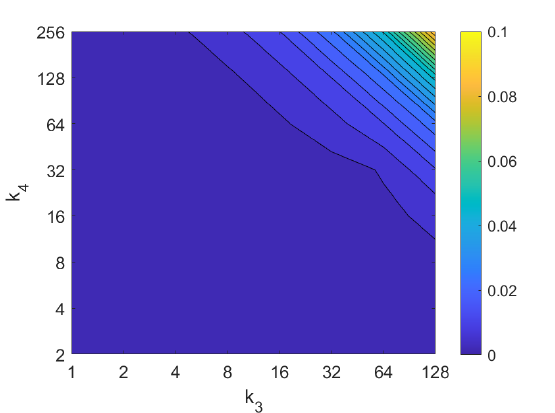
Figure 32. FS orientation estimation. Average computation time